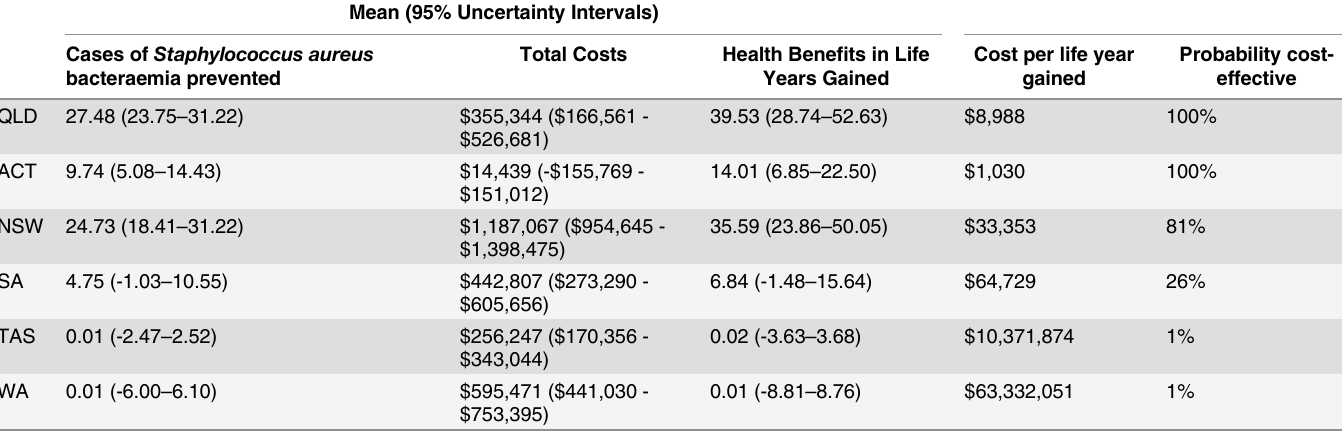
Table 3. Change to outcomes from adoption of National Hand Hygiene Initiative & Probability an Adoption Decision was Cost-Effective. Mean (95% Uncertainty Intervals)